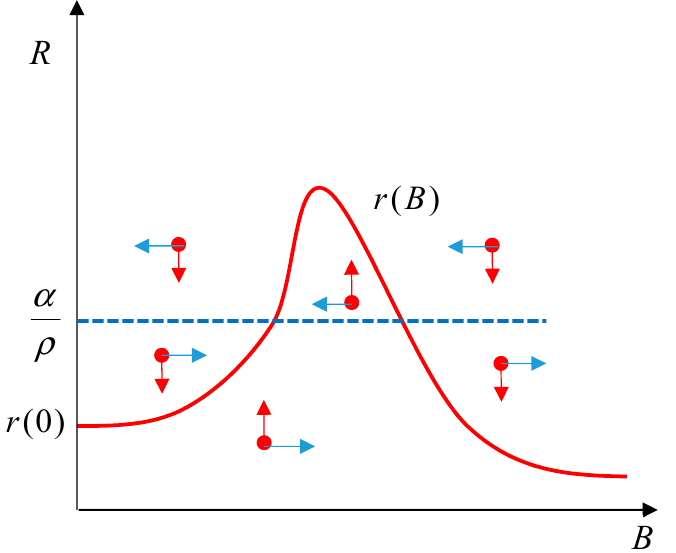
Figure 1. The function r ( B ) and the regions in which state forces and insurgents increase or Figure 1: The function ( ) r B and the regions in which state forces and insurgents increase or decrease.